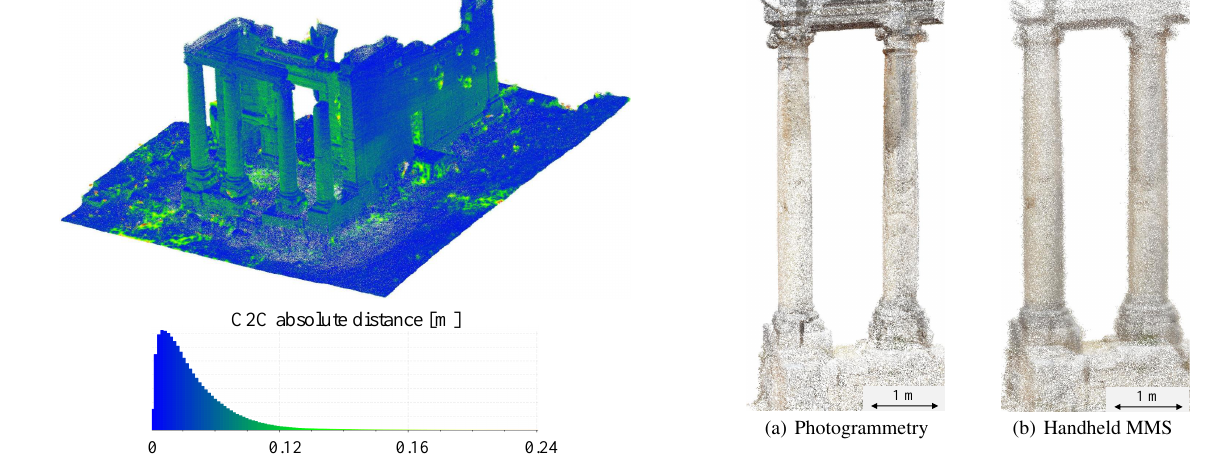
Figure 8. Cloud-to-cloud absolute distances computed between the handheld MMS model and the photogrammetric point cloud. Please note that spots characterized by distances > 10 cm (in light green) are mainly due to the presence of vegetation or data gaps in the photogrammetric point cloud.